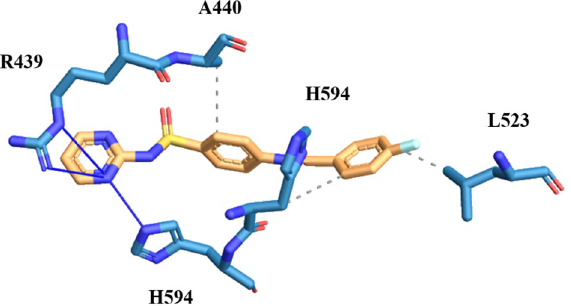
Figure 9. The simulated binding mode of compound 3g in the binding pocket of Jack Bean Urease.